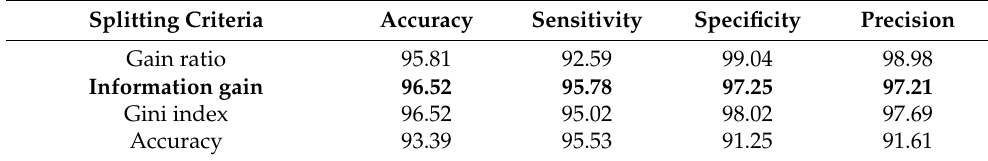
Table 4. The best splitting criteria for the decision tree.